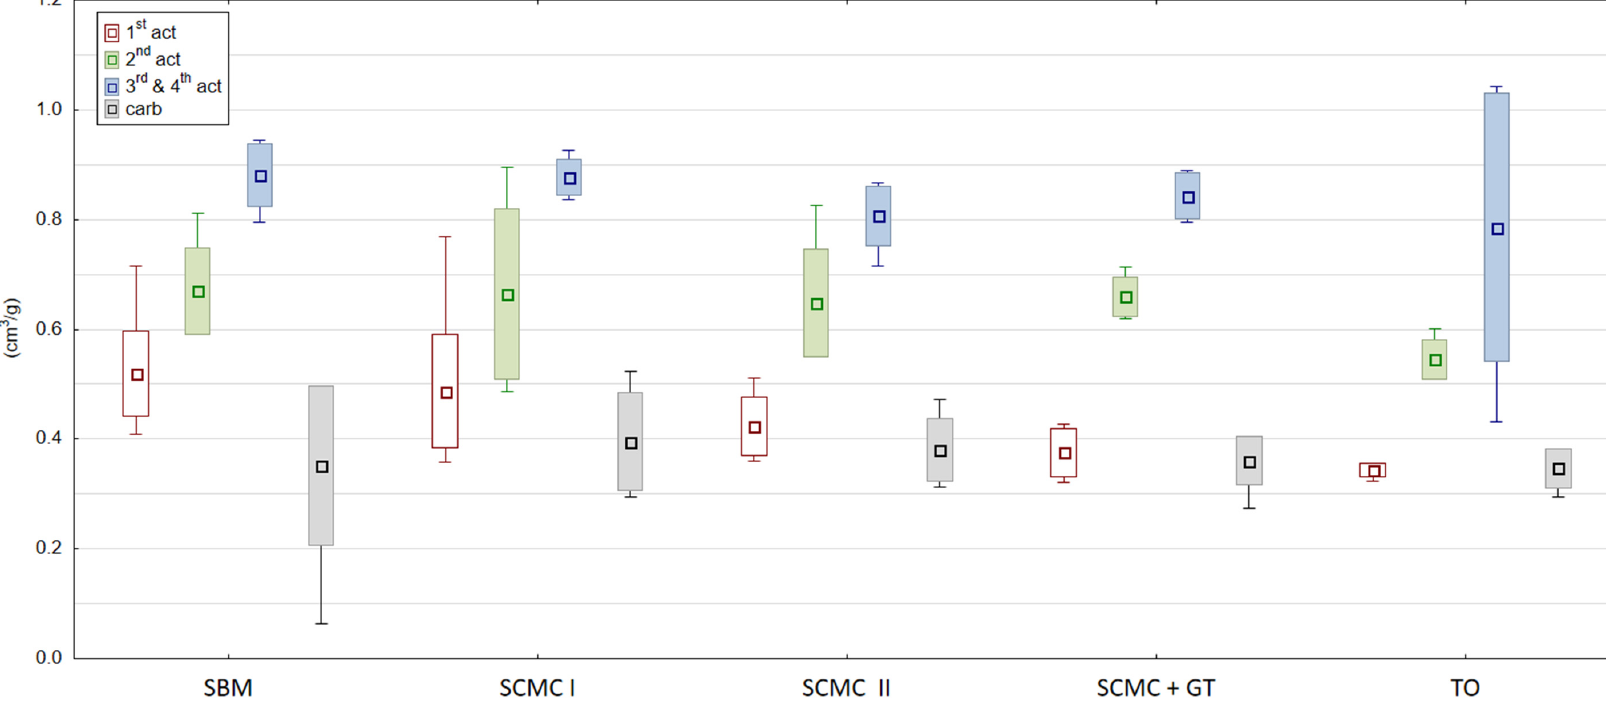
Figure 2. Water absorption of activated carbons after individual production series (cm 3 / g). Source: own elaboration. 1st act—first activation series, 2nd act—second activation series, 3rd and 4th act—third and fourth activation series, carb—carbonization.